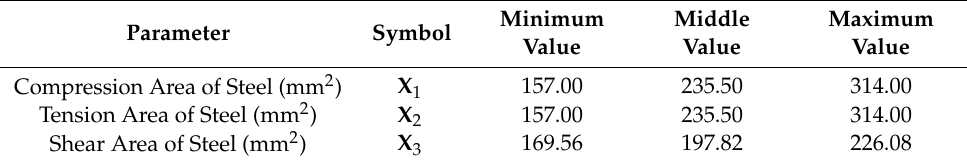
Table 1. Ranges of input parameters.